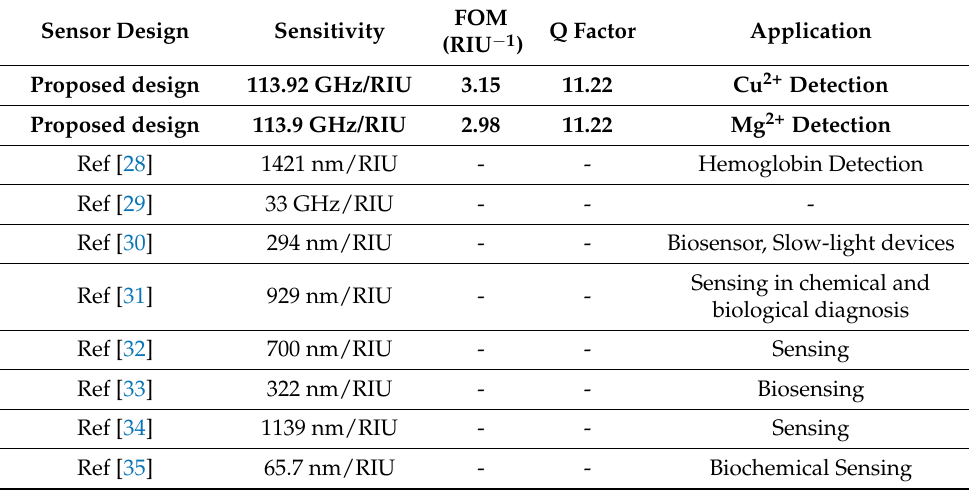
Table 3. Proposed Sensor’s Performance comparison with the available